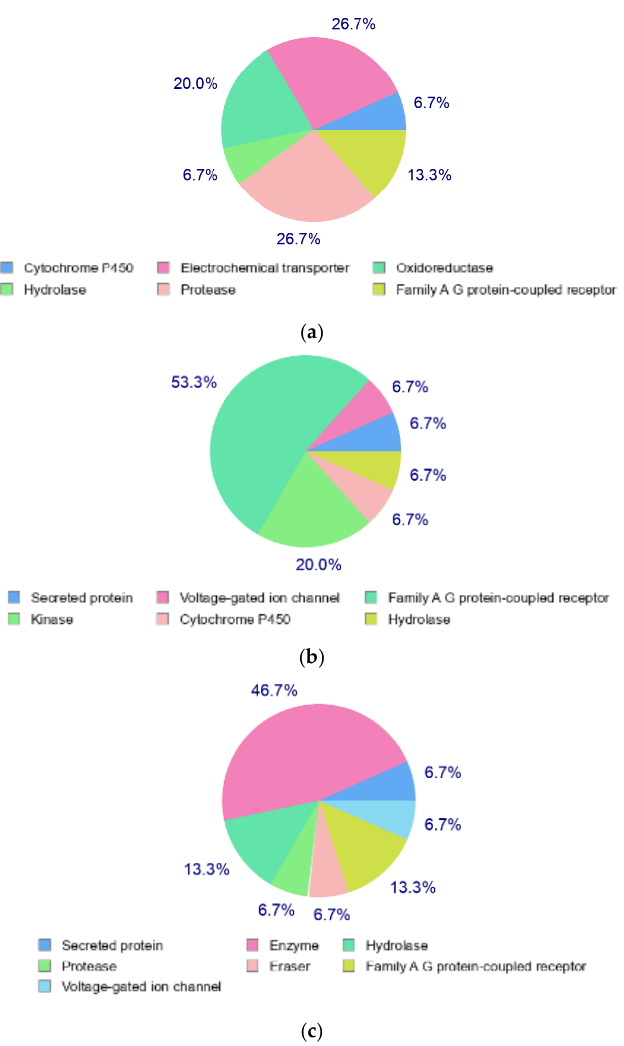
Figure 11. Target classes of compounds ( a ) Naringin ( b ) Eicosane and ( c )